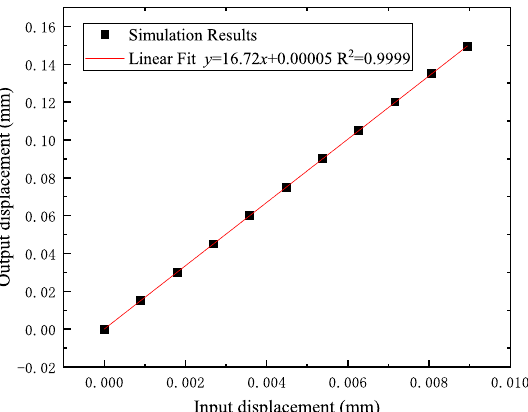
Figure 7. Simulation result of the relationship between output and input